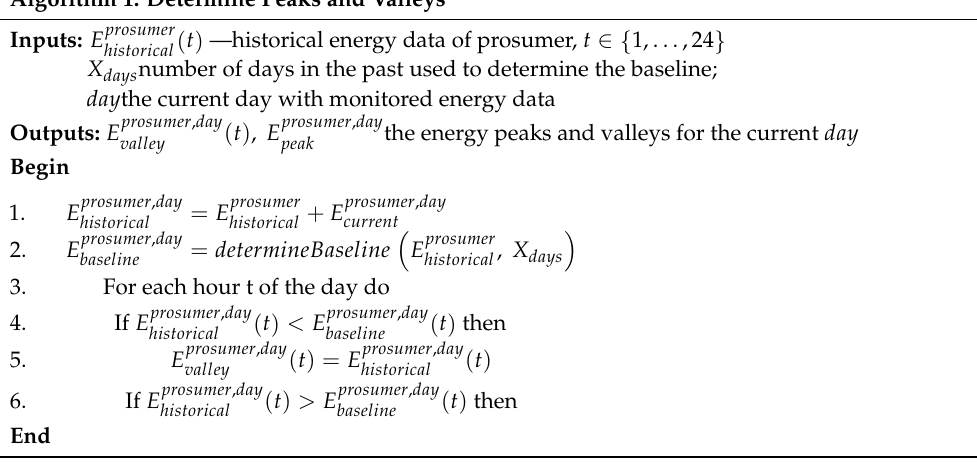
Algorithm 1: Determine Peaks and Valleys